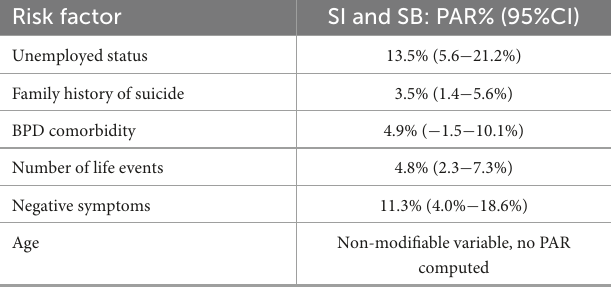
TABLE 4 Population attributable risk percentage derived from multivariate model for suicidal